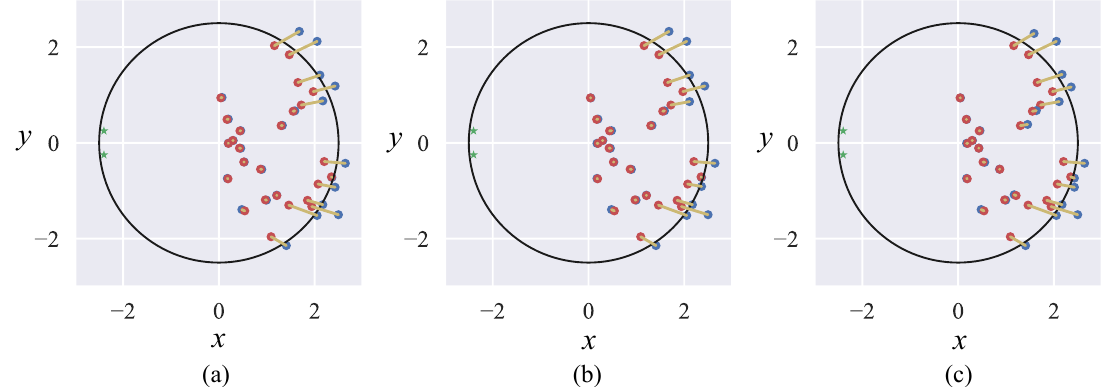
Figure 7. Ground truth and estimated values of the leakage positions of three separated waterdrops . The results of all ten different scenes are combined together. Only detected waterdrops are illustrated. ( a ) Noise level L. ( b ) Noise level M. ( c ) Noise level H. The red and blue dots indicate the ground truth and estimated leakage positions, respectively. The yellow lines illustrate the correspondence of the ground truth with the estimated leakage positions. The camera positions are also illustrated as the greed dots for